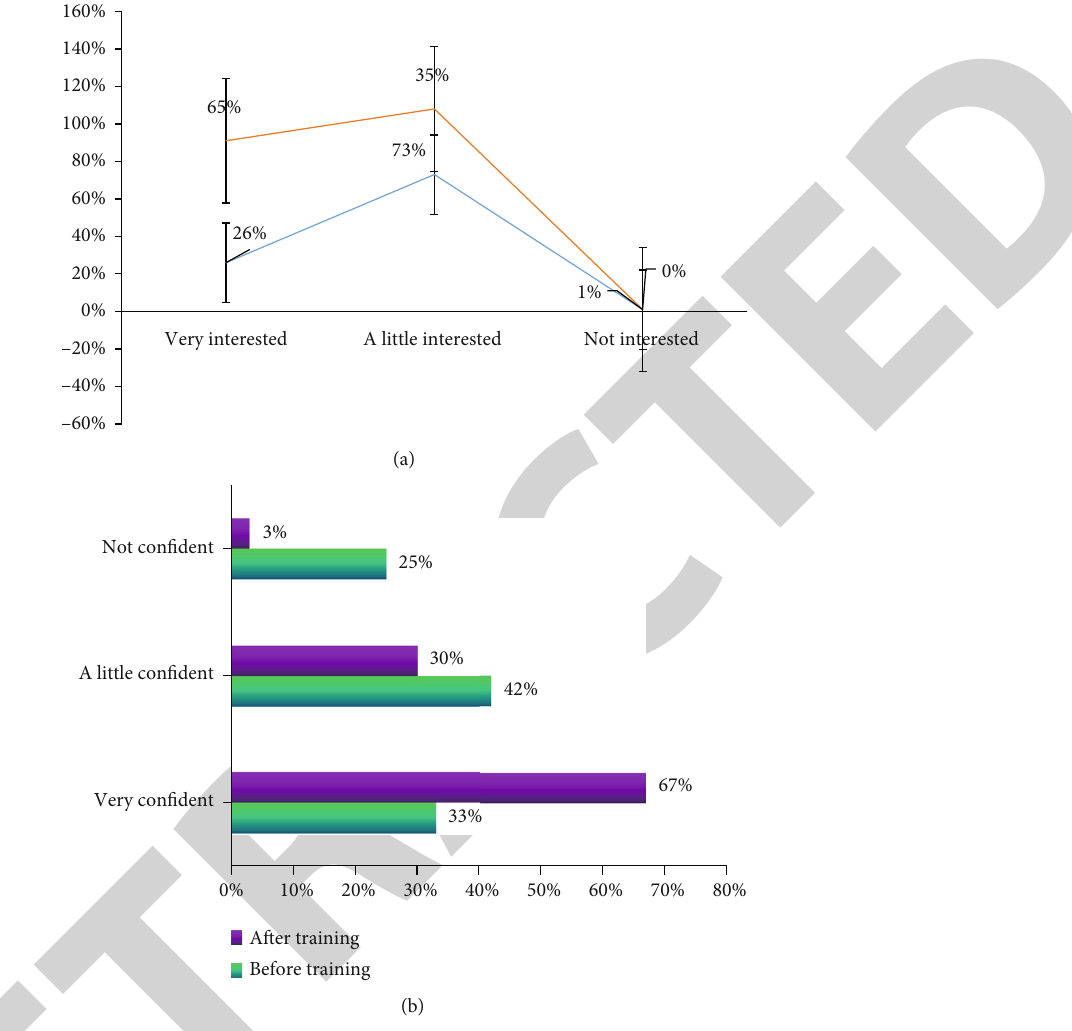
Figure 10: Comparison of interest and self-con fi dence of athletes before and after the